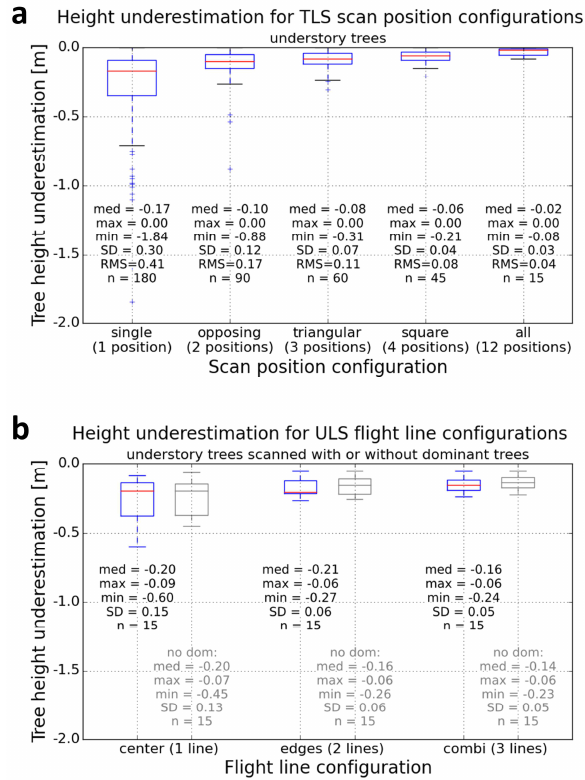
Figure 5: Differences between individual 3D triangle mesh tree model reference height values and respective height extracted from synthetic point clouds. (a) TLS scan positions, (b) ULS flight strips (grey: simulation without dominant trees) Similar in case of the ULS flight strip configurations (Figure 5b), where the combination of the two flight lines captured along the edge of the forest plot reduces the scatter of tree height underestimation values. The magnitude of the maximum tree height underestimation of 0.09 m (5.45%) is